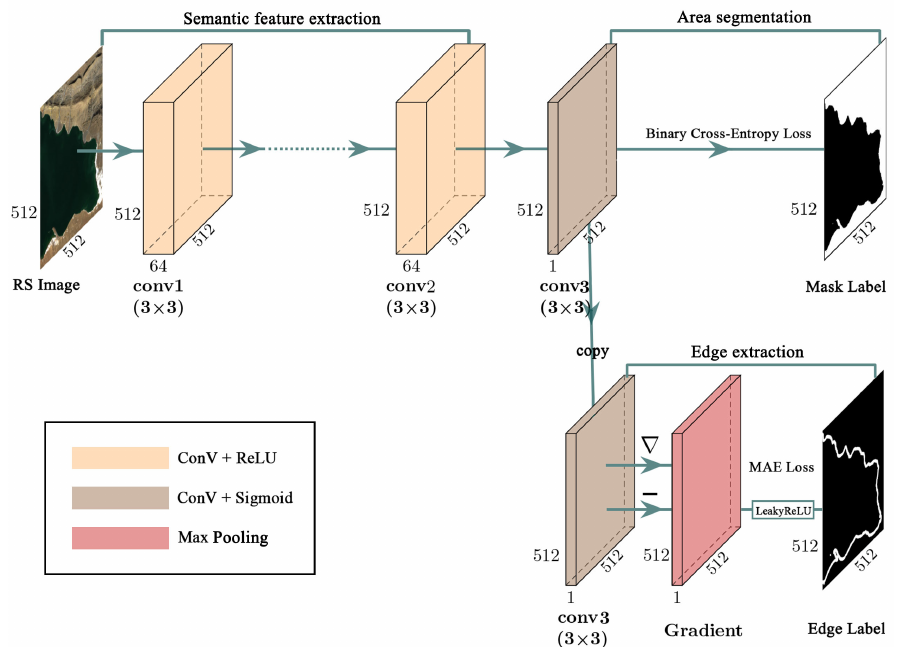
Figure 1. The architecture of our proposed LaeNet model for automatically and simultaneously extracting lake area and shoreline. The wheat boxes represent multichannel convolutional layers for semantic feature extraction. The khaki box is a single-channel convolutional layer for area segmenta- tion. The red box indicates the gradient of the segmented area by using the max pooling